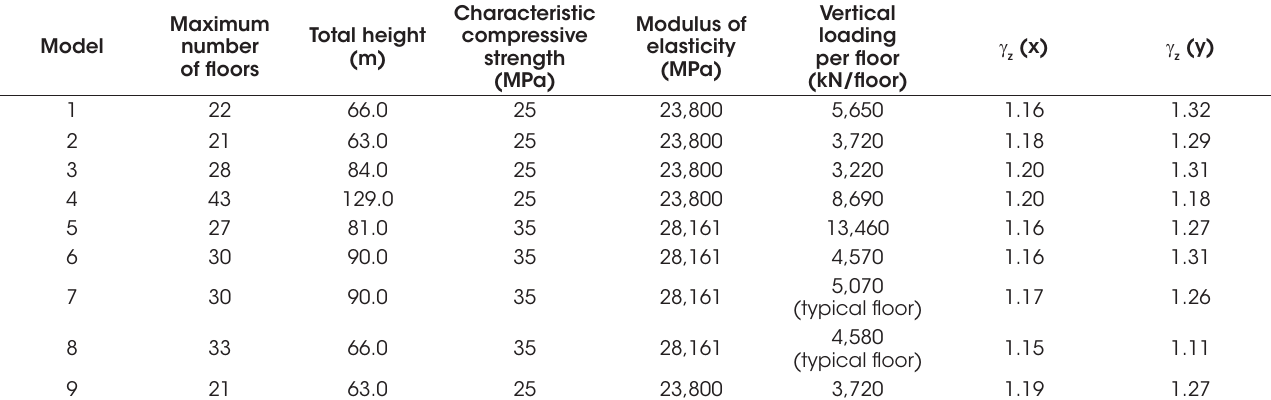
Assessed models characteristics